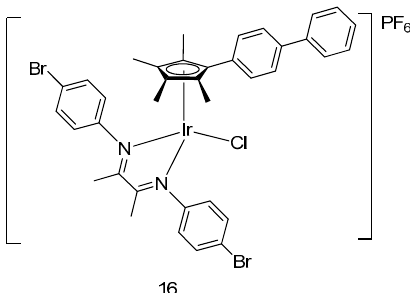
Figure 6 . Organometallic half-sandwich iridium(III) complex 16 .